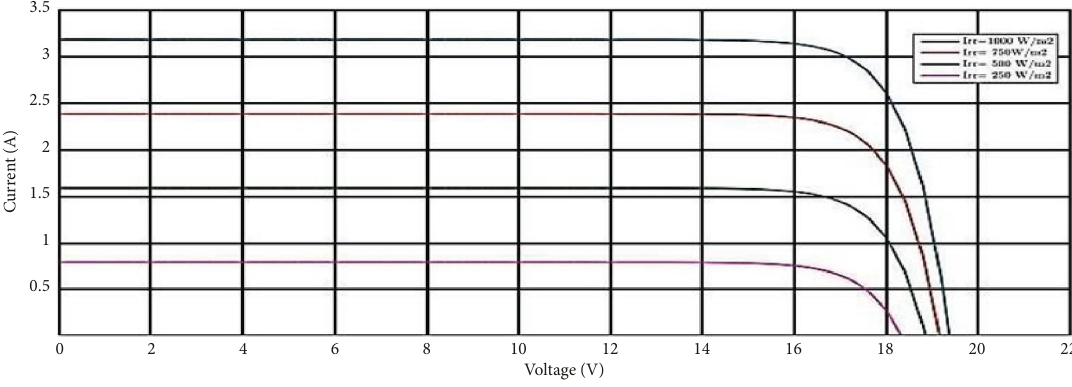
Figure 3: I–V parameters of a photovoltaic cell.